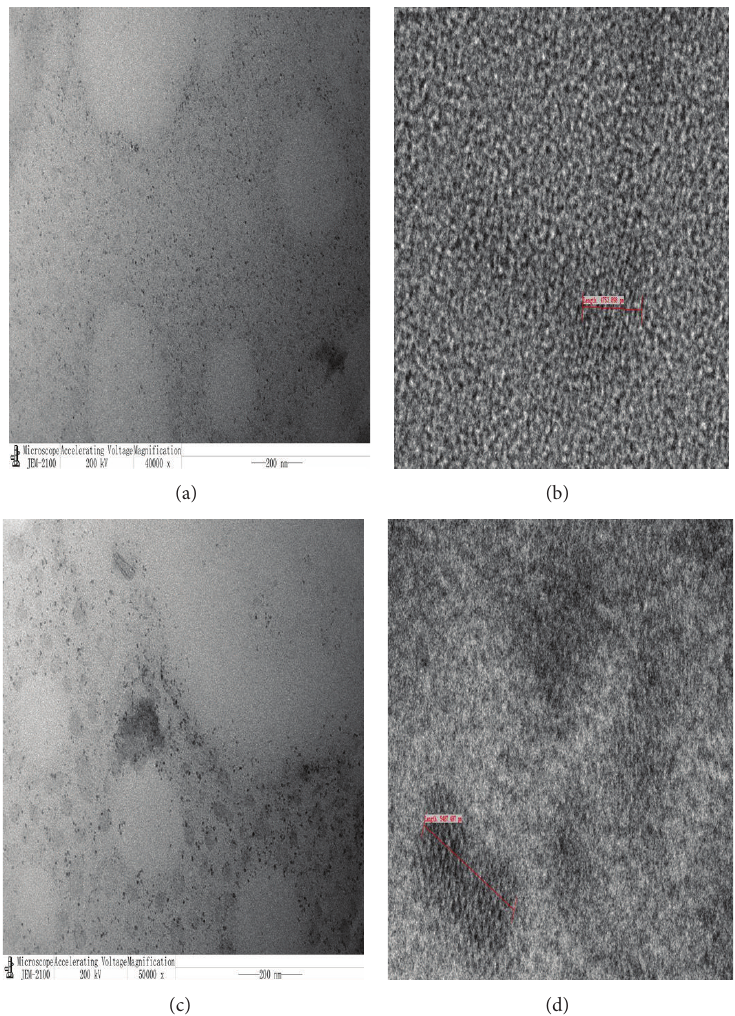
= 6.0× 10 −4 mol / L; 𝑐 4.0 g / mL; c = ( CdS ) 𝑛 CdS ) 𝑛 HSA ( CdS ) ( CdS ) 𝑛 , (b) shows the details of the 𝑛 . (c) Typical HRTEM image of the 𝑛